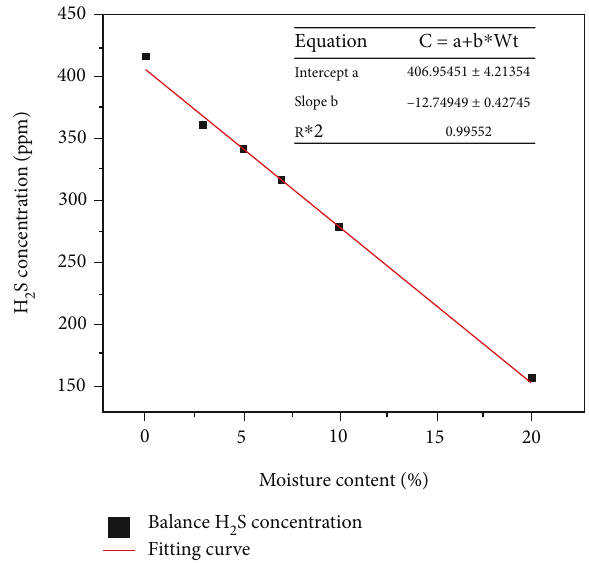
S concentration. Figure 9: Changes of total sulfur content of coal before and after 2 adsorption of H 2